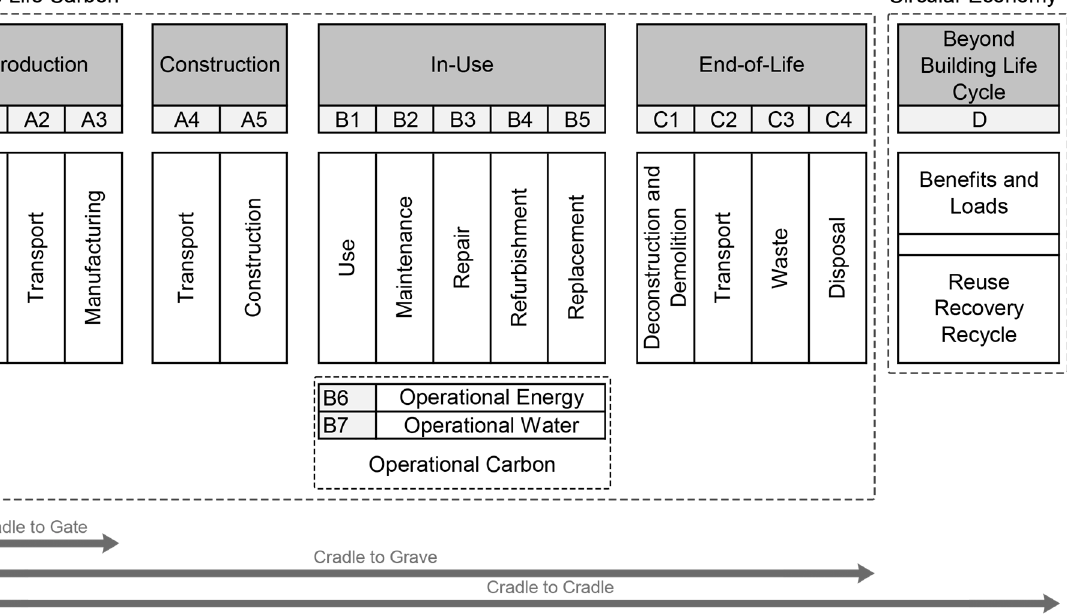
Figure 4. Whole Life Cycle Assessment Benchmarks by Building Type [17–19].